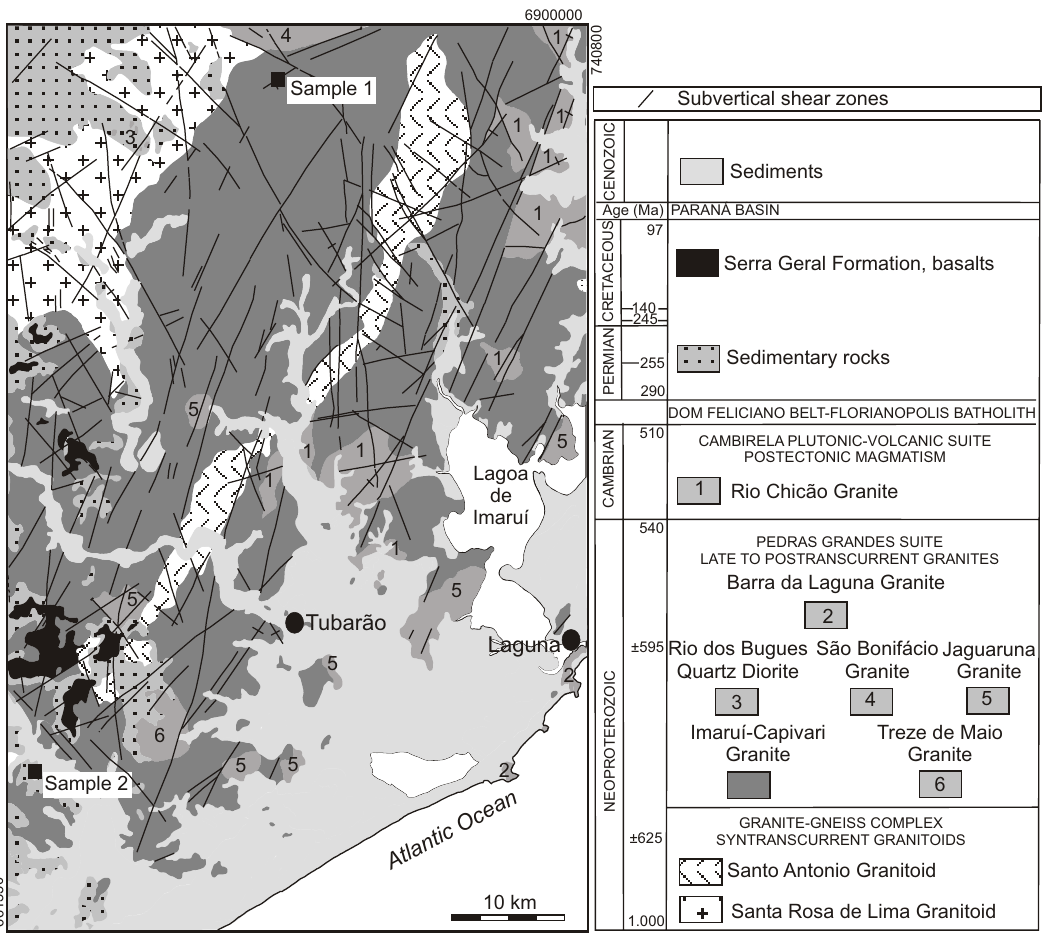
Fig. 1 – Location map. Modified after Silva et al.